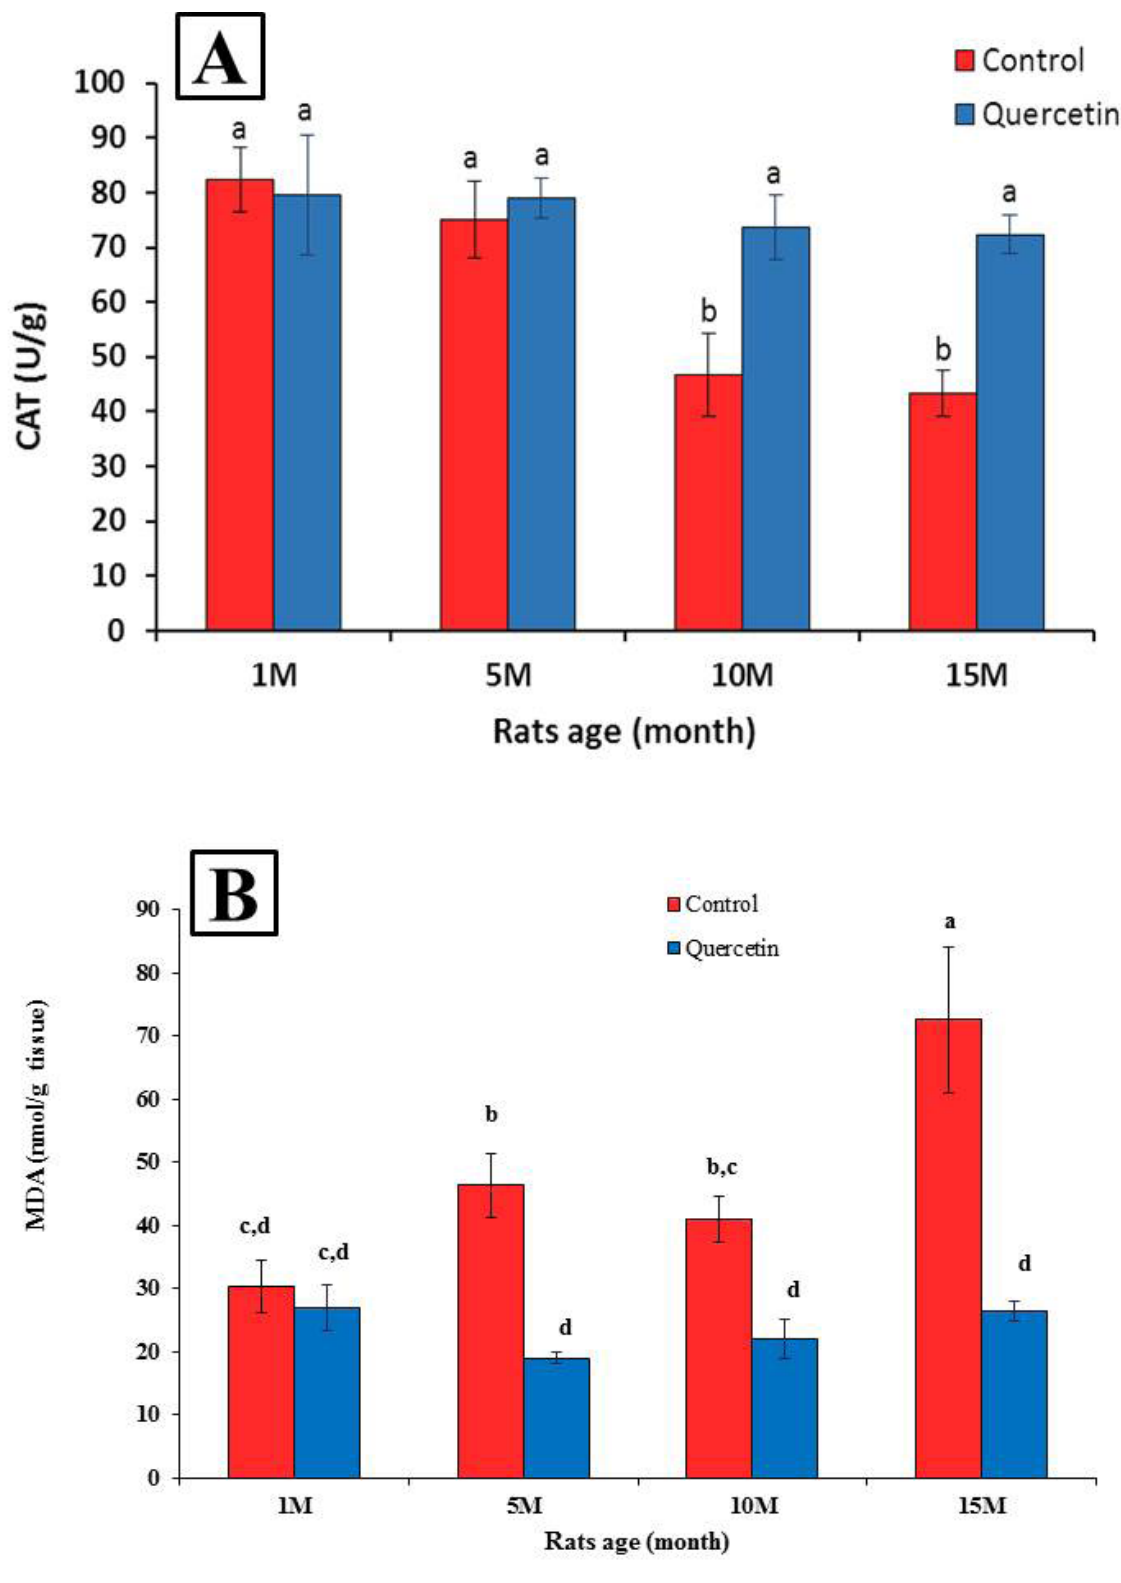
FIGURE 1 - Effect of quercetin on the activity of both CAT and MDA enzymes in the rats that had 1, 5,10 and 15 month old (1 M, 5 M, 10 M and 15 M), respectively. Control and quercetin: Rats that were taken a vehicle and quercetin, respectively Data are means ± SE with n=3, Different letters indicate significant differences among the columns (p ≤